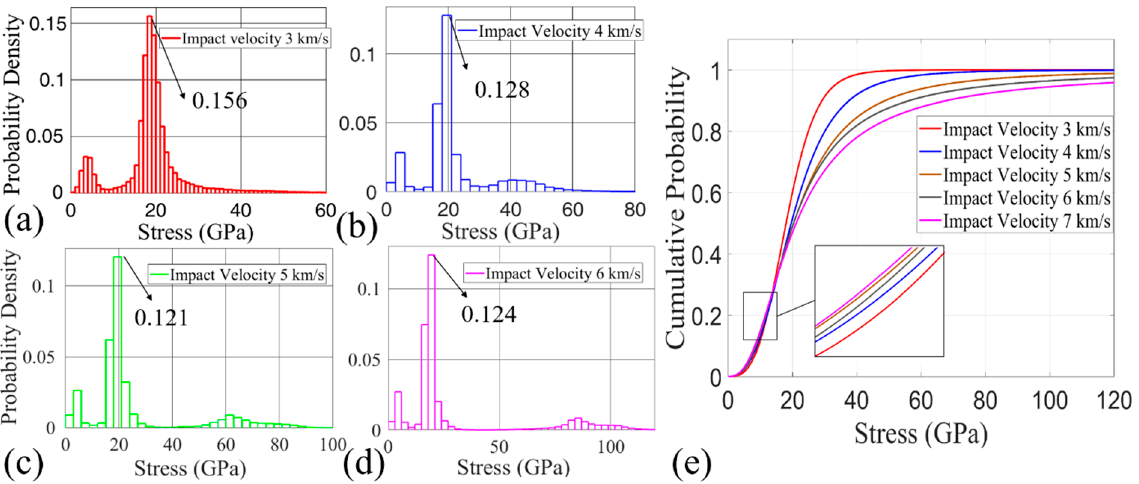
Figure 6. Von Mises atomic stress distribution of Ti 8 C 5 prior to bond break, when it subject to impact velocity: ( a ) 3 km/s; ( b ) 4 km/s; ( c ) 5 km/s; ( d ) 6 km/s. ( e ) Cumulative density function (CDF) of the Von Mises atomic stress distribution before the crack initiation for different nanosheets under diverse impact velocities.